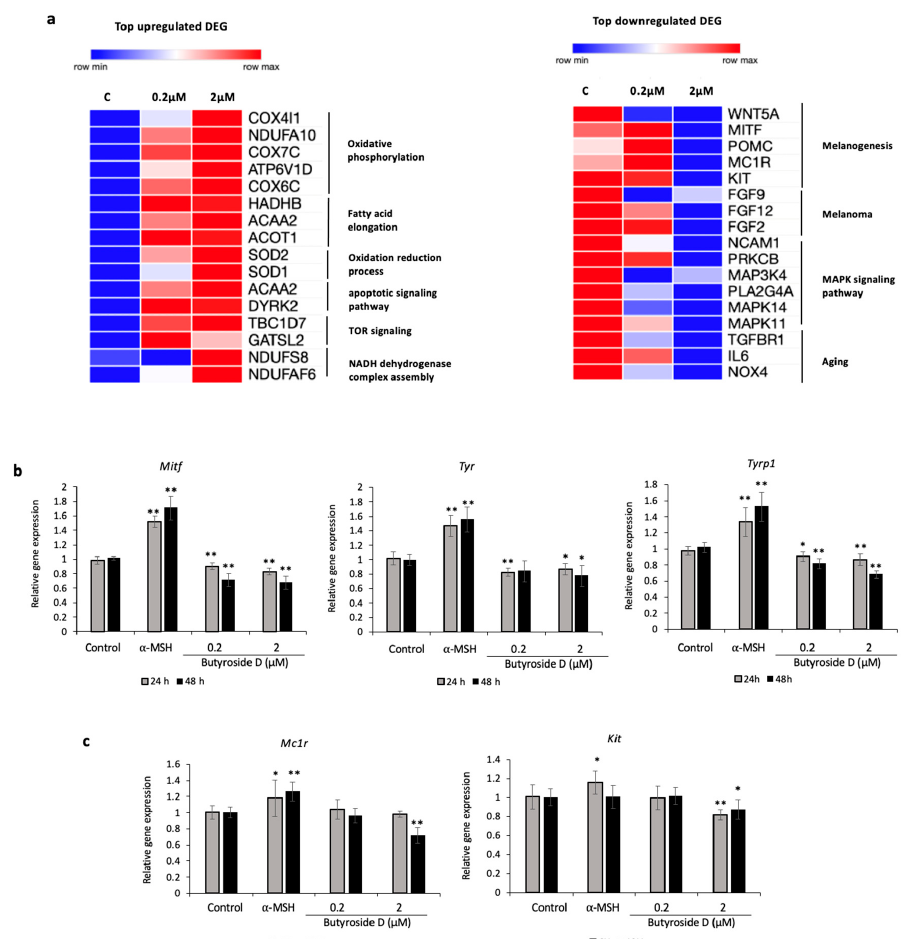
Figure 5. Butryoside D decreased the gene expression levels of melanogenesis-related genes in B16F10 cells. ( a ) Heatmaps displaying the relative expression levels of the top up- and downregulated genes by 0.2 and 2 μ M Butryoside D. The related biological functions and pathways were also displayed. These heatmaps are generated by the online tool Morpheus Broad Institute. ( b ) Gene expression levels of Mitf, Tyr, Tyrp1, (24 h, 48 h) ( c ) Mc1r, and Kit (6 h, 12 h) were assessed using quantitative RT-PCR analysis. Results are presented as mean ± SD ( n = 3). Statistical analysis was performed using one-way ANOVA where asterisks denote significant differences between the control and test groups being * p < 0.05 and ** p <